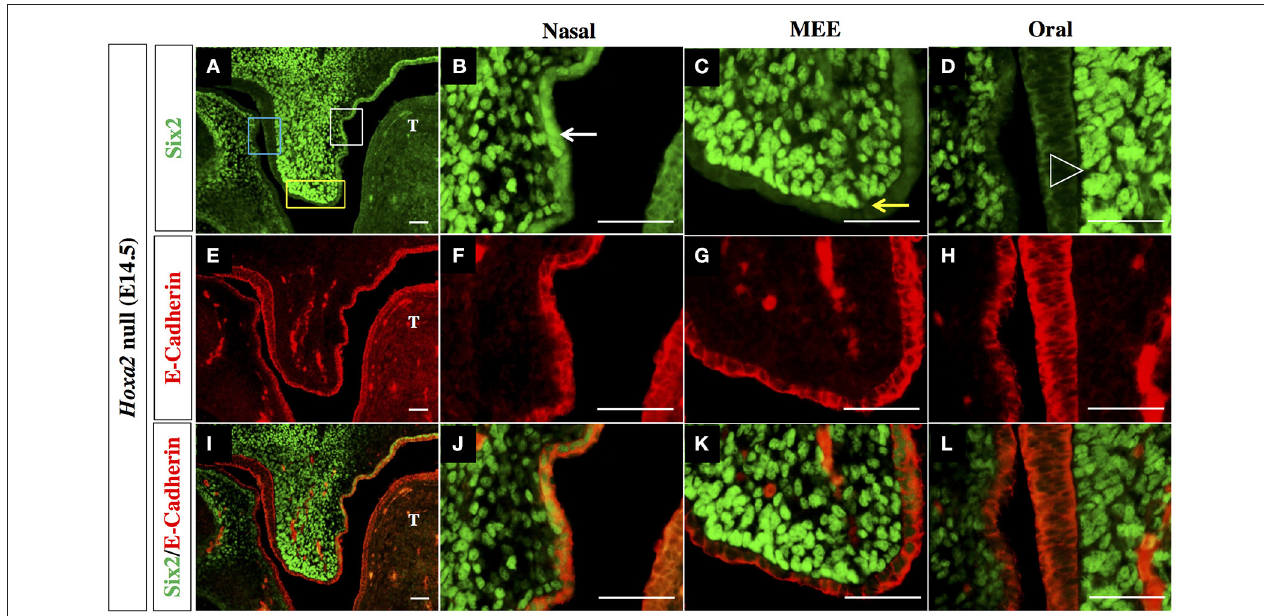
FIGURE 4 | Six2 protein is exclusively expressed in epithelium on the nasal side of the palatal shelf in Hoxa2 − / − mice . IHC staining of mid-coronal sections of Hoxa2 null palatal shelves at E14.5 for Six2 (A–D) , E-Cadherin (E–H) , and overlays of the Six2 and E-Cadherin immunofluorescence images (I–L) . Expression of Six2 protein within the palatal epithelium is restricted to epithelial cells located on the nasal side of the palatal shelf (marked by white rectangle in panel (A) , and by white arrow in the higher magnification image (B) . Six2 is absent from epithelial cells located on the oral side of the palatal shelf (marked by blue rectangle in A , and by position of arrowhead in higher magnification image D ). Within Hoxa2 − / − embryos, Six2 is also absent from cells of the medial edge epithelium (MEE) which is located at the apical tip of the palatal shelf (marked by yellow rectangle in (A), and by yellow arrow in higher magnification image (C). Because palatal shelves of Hoxa2 − / − fail to elevate and make contact, they do not form an MES. The entire surface epithelium of Hoxa2 − / − palatal shelves (on both its nasal and oral sides, as well as within the MEE) expresses E-cadherin (E–H, I–L). MEE, medial edge epithelium; T, tongue. Scale bars, 50 µ m. The IHC staining images shown are representative of palatal sections from a minimum of 5